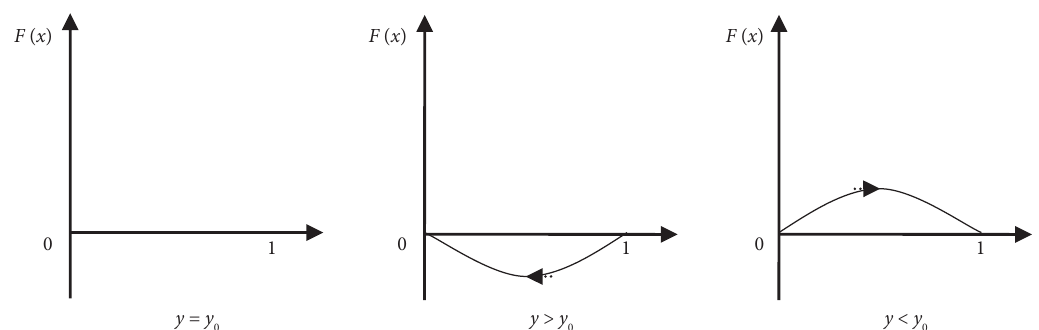
Figure 1: Replicated dynamic phase diagram of the platform